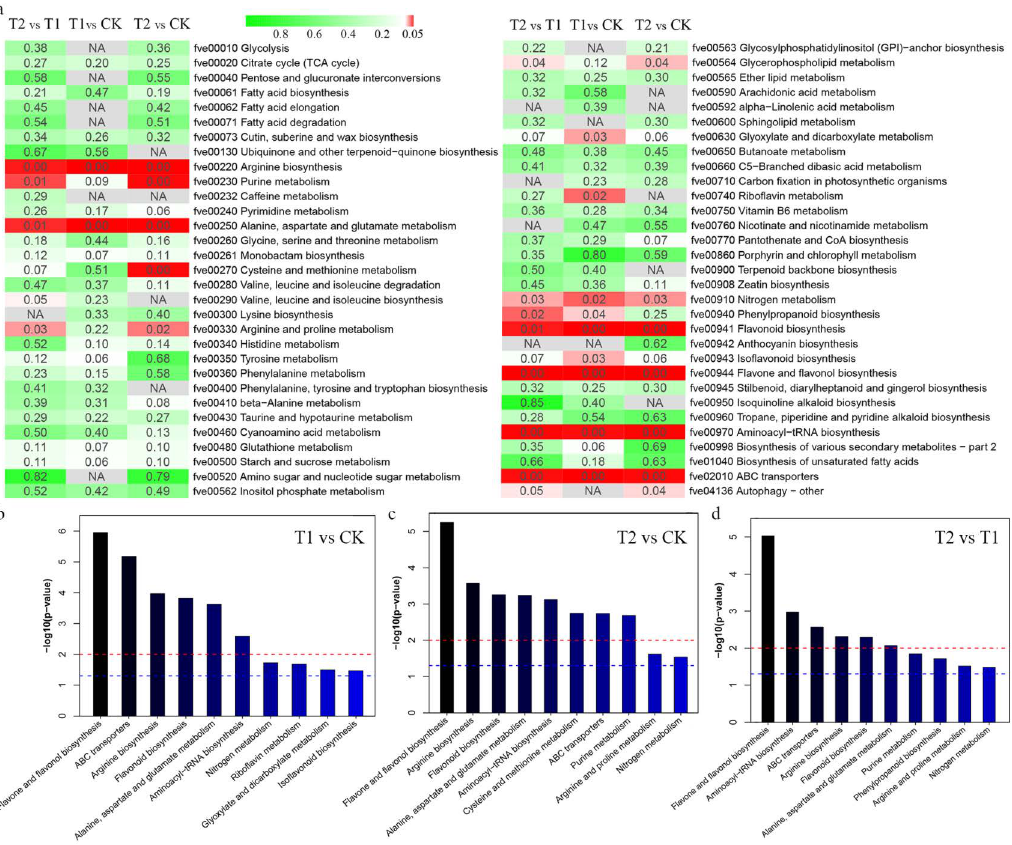
Figure 5. KEGG pathway enrichment analysis based on differentially expressed metabolites (DEMs). ( a ) The main enriched metabolic pathways of the DEMs. ( b – d ) The top 10 enriched KEGG pathways. The horizontal coordinate is the name of the pathway, the vertical coordinate is the − log10 ( p value) and the two horizontal dashed lines represent the positions of p < 0.01 and p <